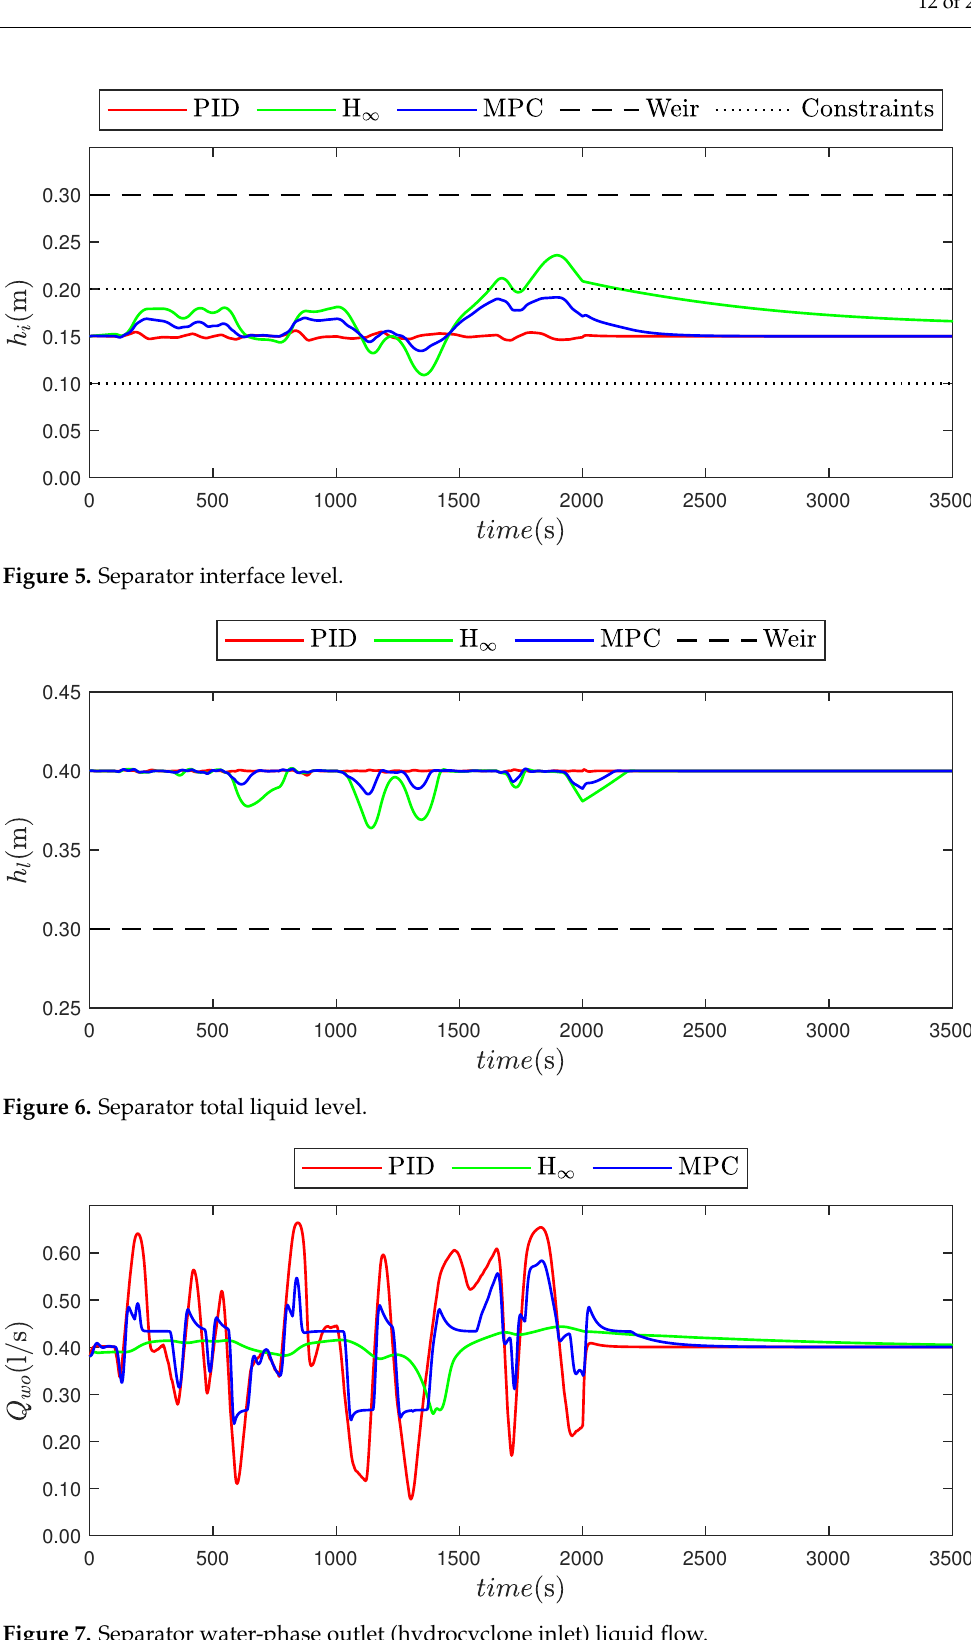
Figure 7. Separator water-phase outlet (hydrocyclone inlet) liquid